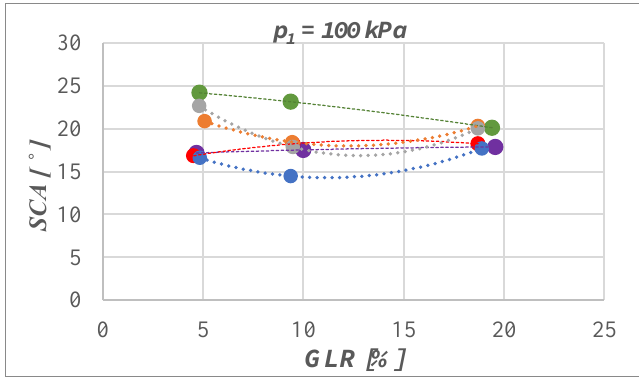
Fig. 9. The influence of GLR on SCA for p 1 = 100 kPa .